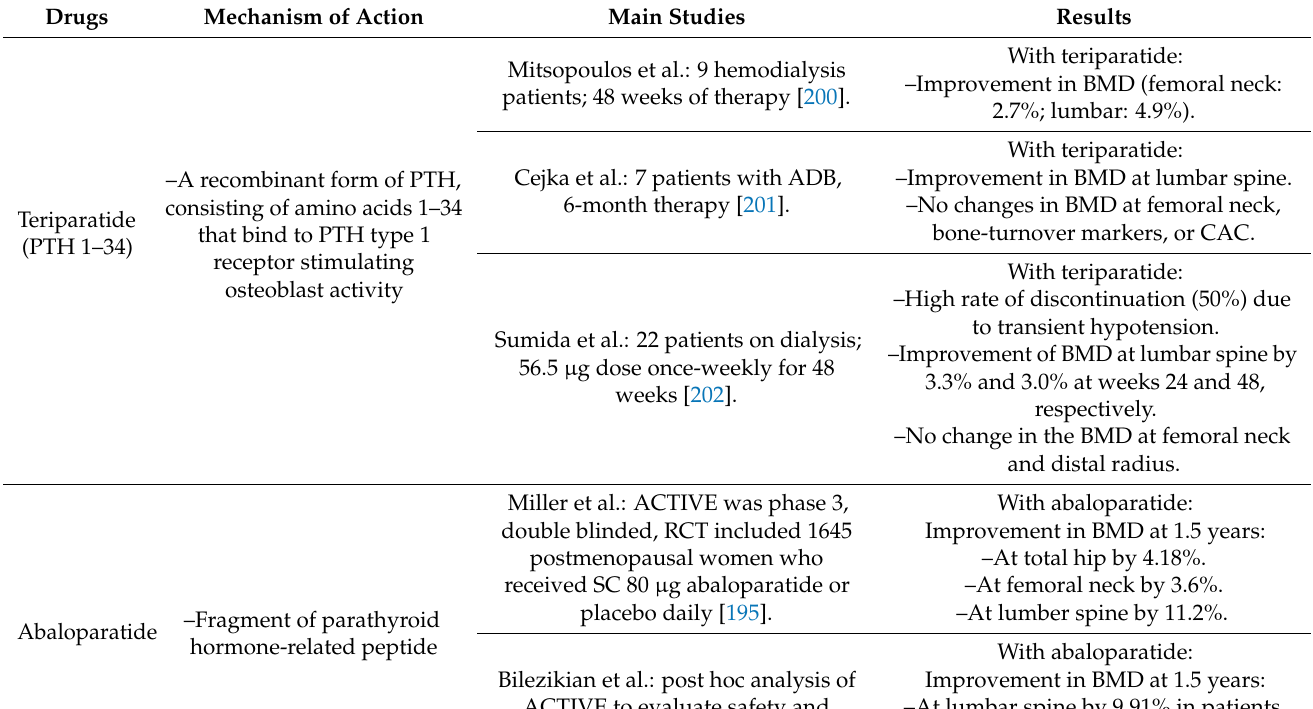
Table 2. Osteo-anabolics used for treatment of